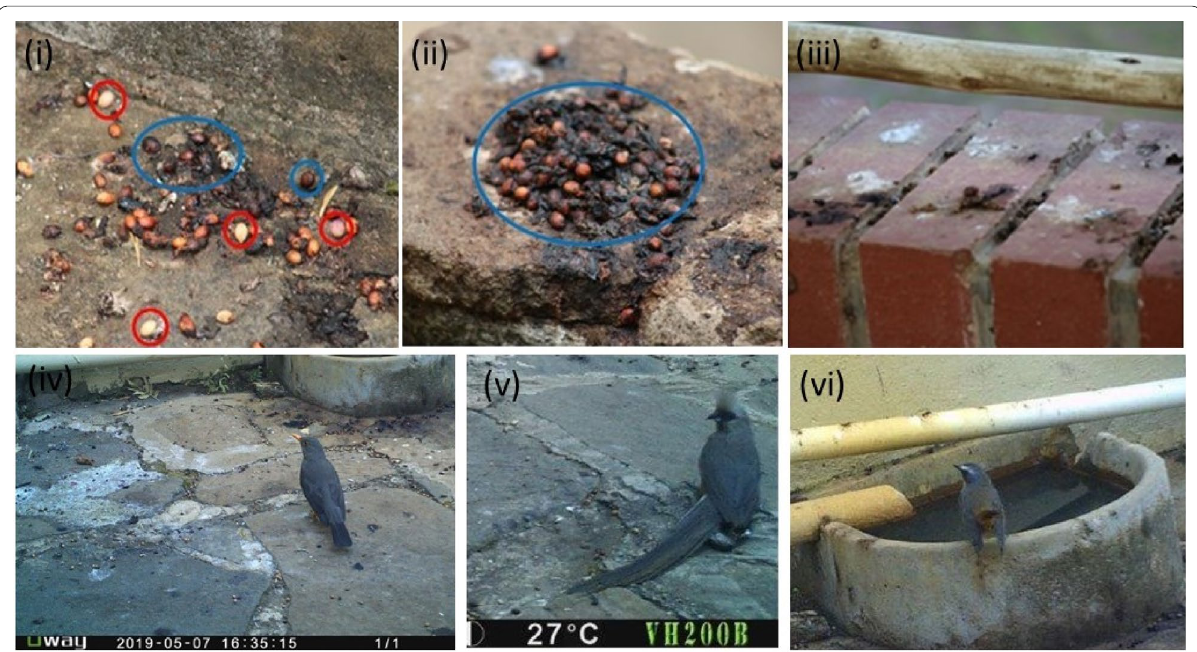
Fig. 2 Birds roosting areas: faecal samples were collected during the study (i–iii). Red circle shows regurgitated seeds and blue circle shows defecated seeds. Common bird species that ingested and defecated intact seeds included (iv) olive thrush Turdus olivaceus , (v) speckled mousebird